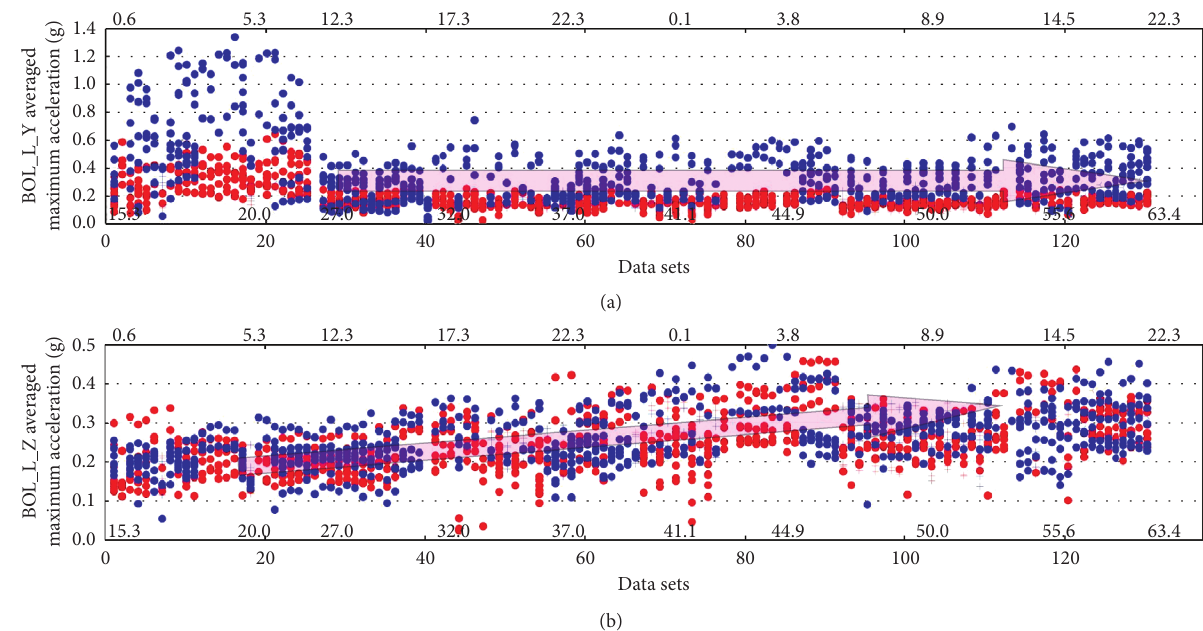
Figure 7: Evolution of the unfiltered acceleration on the CB chassis in (a) lateral and (b) vertical